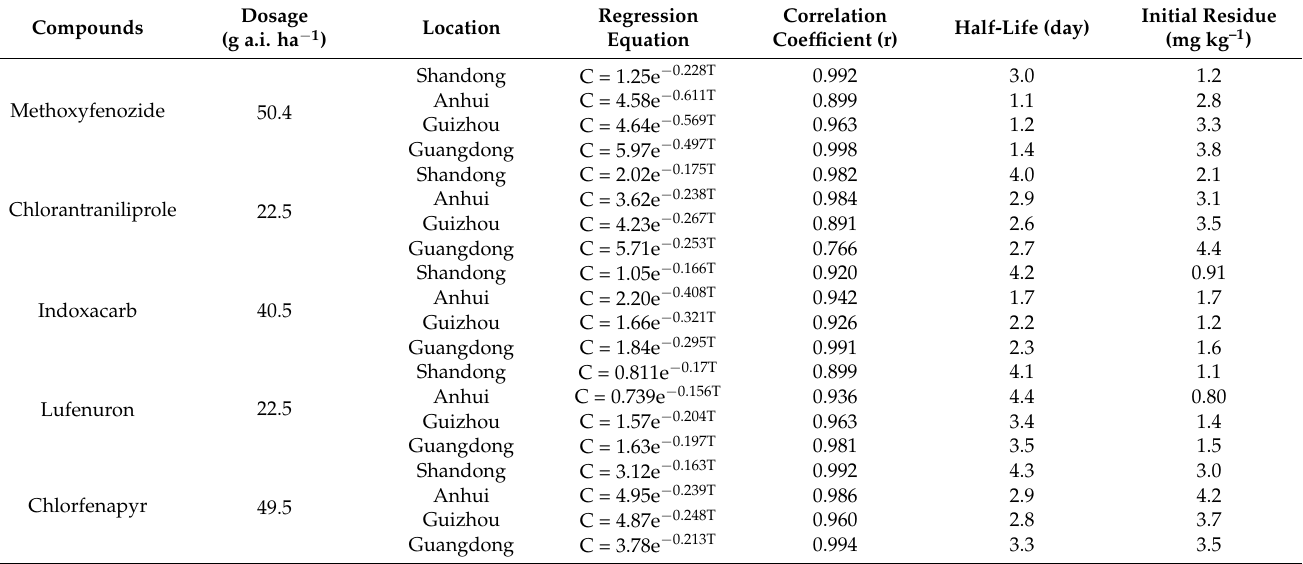
Table 3. Dissipation dynamics parameters of the five compounds in spinach at the four